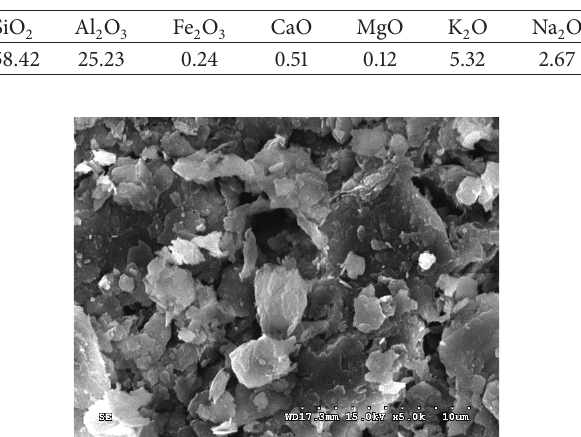
Table 2: The chemical constituents of the clay (%).